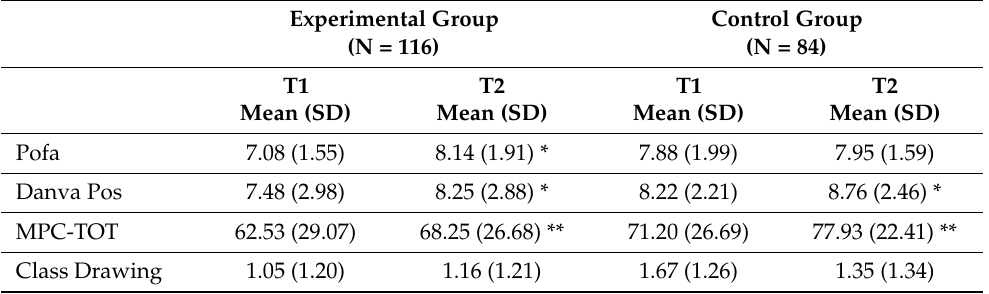
Table 2. Scale scores for experimental and control groups at baseline (T1) and post-intervention follow-up